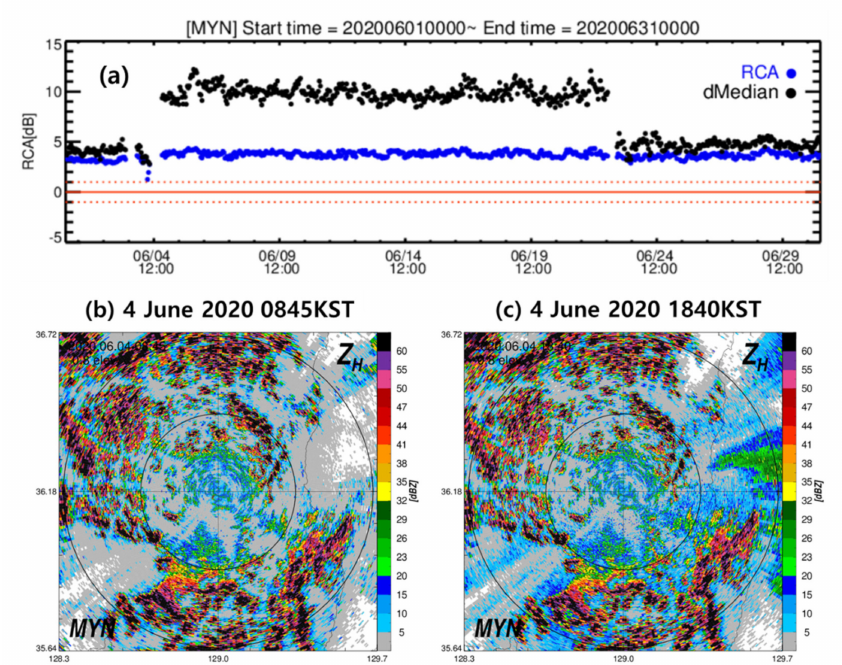
Figure 9. Example of azimuth angle slip issue. ( a ) Time series of ground clutter (GC) reflectivity statistics for MYN radar from 0000 KST 1 June 2020 to 0000 6 June 2020. The black and blue dots represent the RCA and dMedian. ( b , c ) PPIs of Z H at the elevation angle of − 0.8 ◦ of MYN radar at 6 June 2020 0845 KST and 1840 KST. The rings are intervals of 30